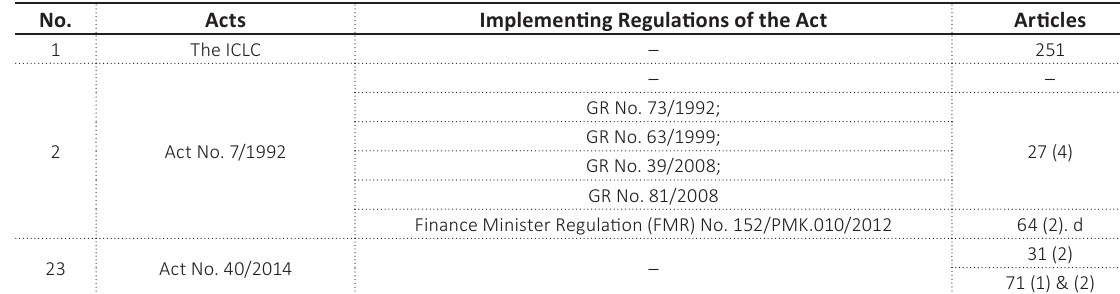
Source: Processed from various